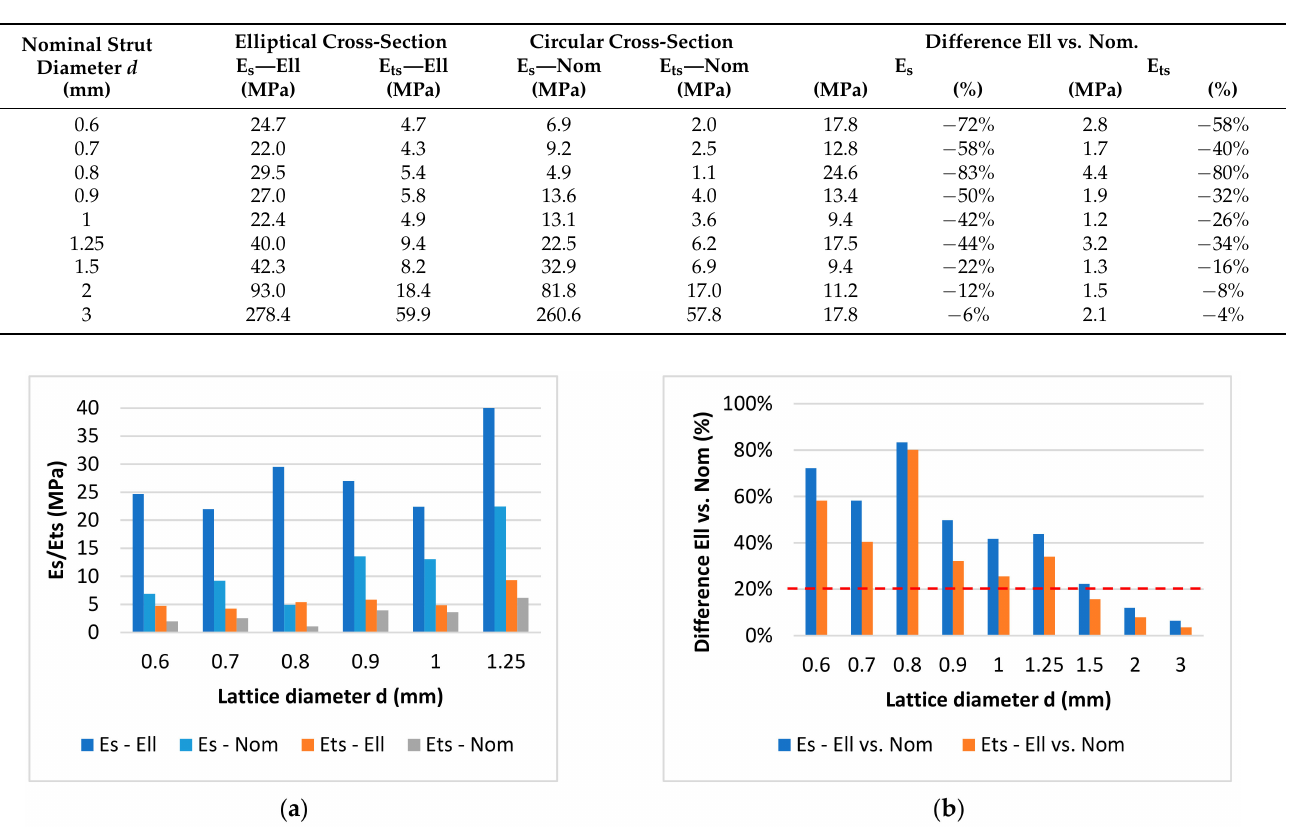
Figure 15. ( a ) Comparison of average stress–strain response of lattice structures with different strut diameters, up to the nominal diameter of 1.25 mm. ( b ) Comparison of the relative deviations of the nominal circular cross-section (Nom.) and actual elliptical cross-section